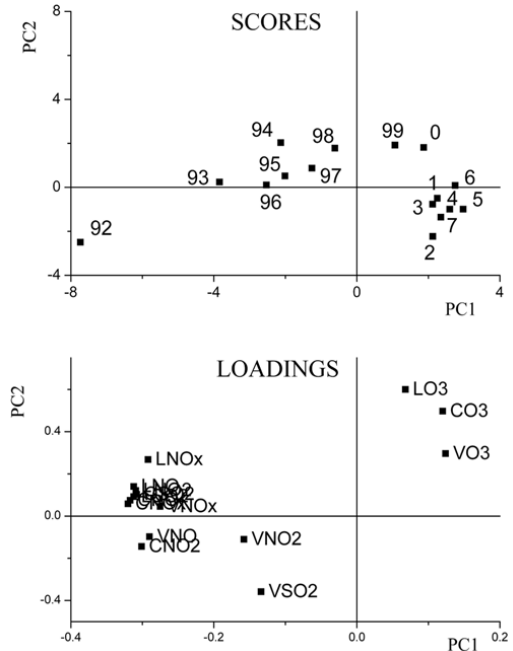
Figure 5. Score plot and loading plot for the PCA model performed on the 16 years × (5 variables × 3 sites) data matrix (62% PC1, 14% PC2). Variables are labeled with the first letter indicating the site (C = Como, V = Varenna, L = Lecco) followed by the chemical name.